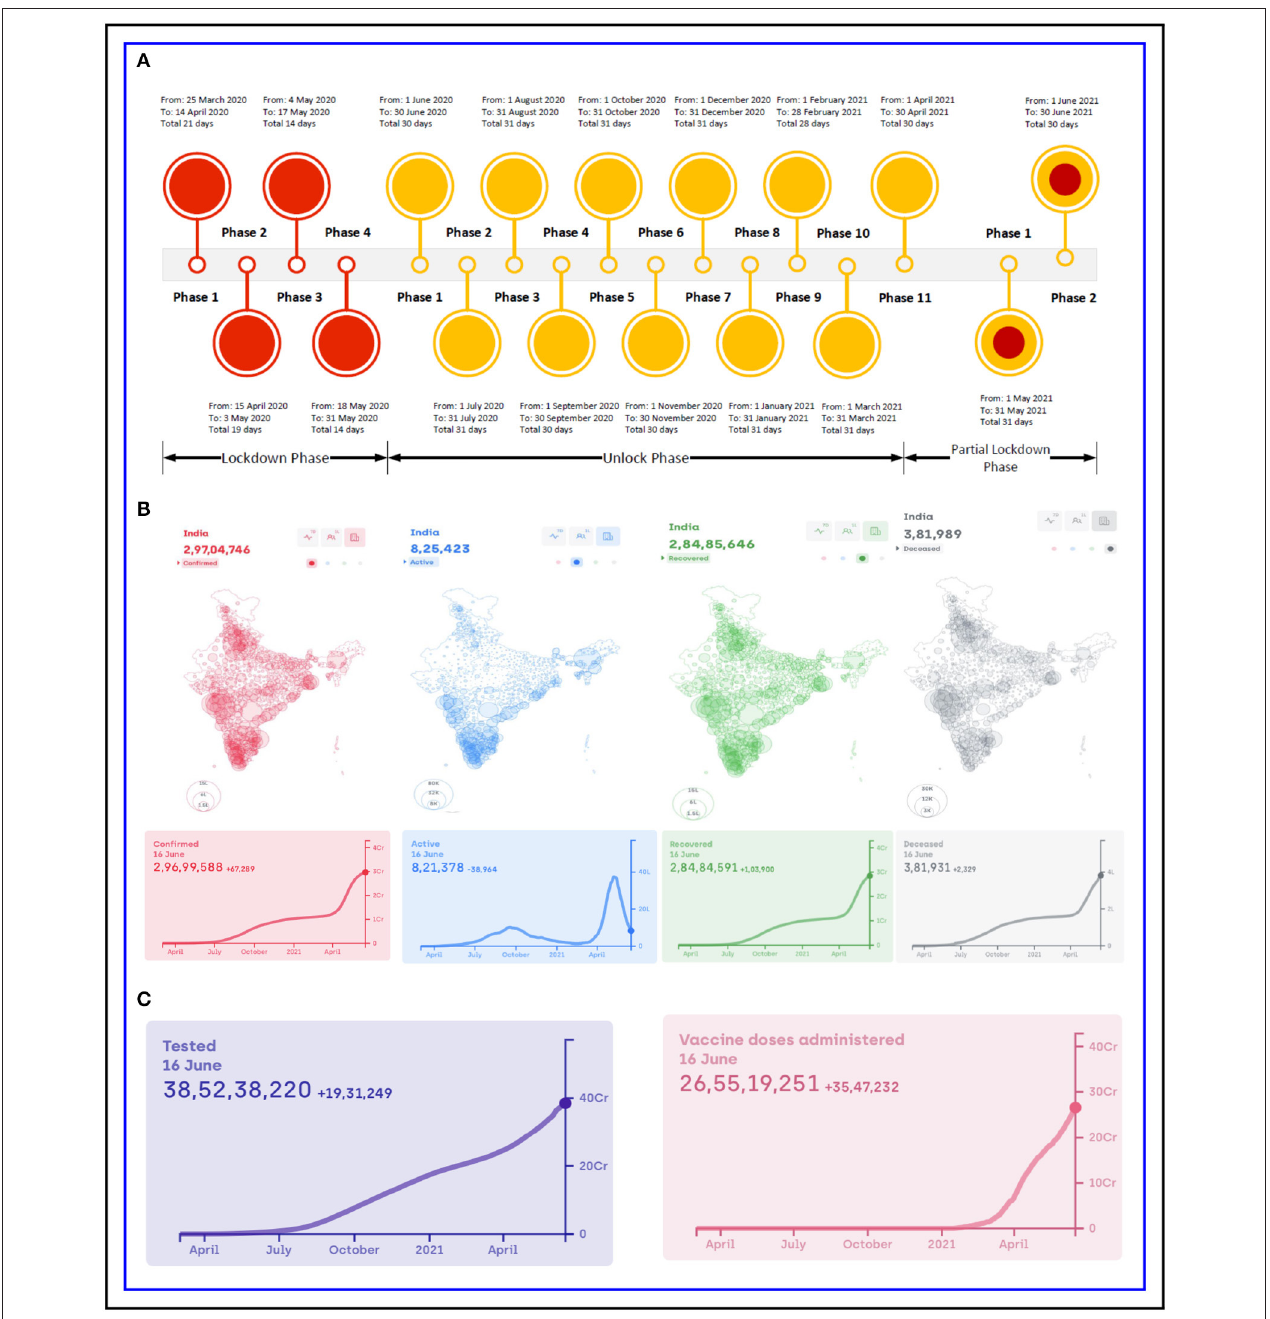
FIGURE 1 | India: (A) Chronology of lockdown, unlock phases and partial lockdown phases, (B) number of confirmed, active, recovered and deceased cases and (C) total number of people tested and vaccine doses administered.